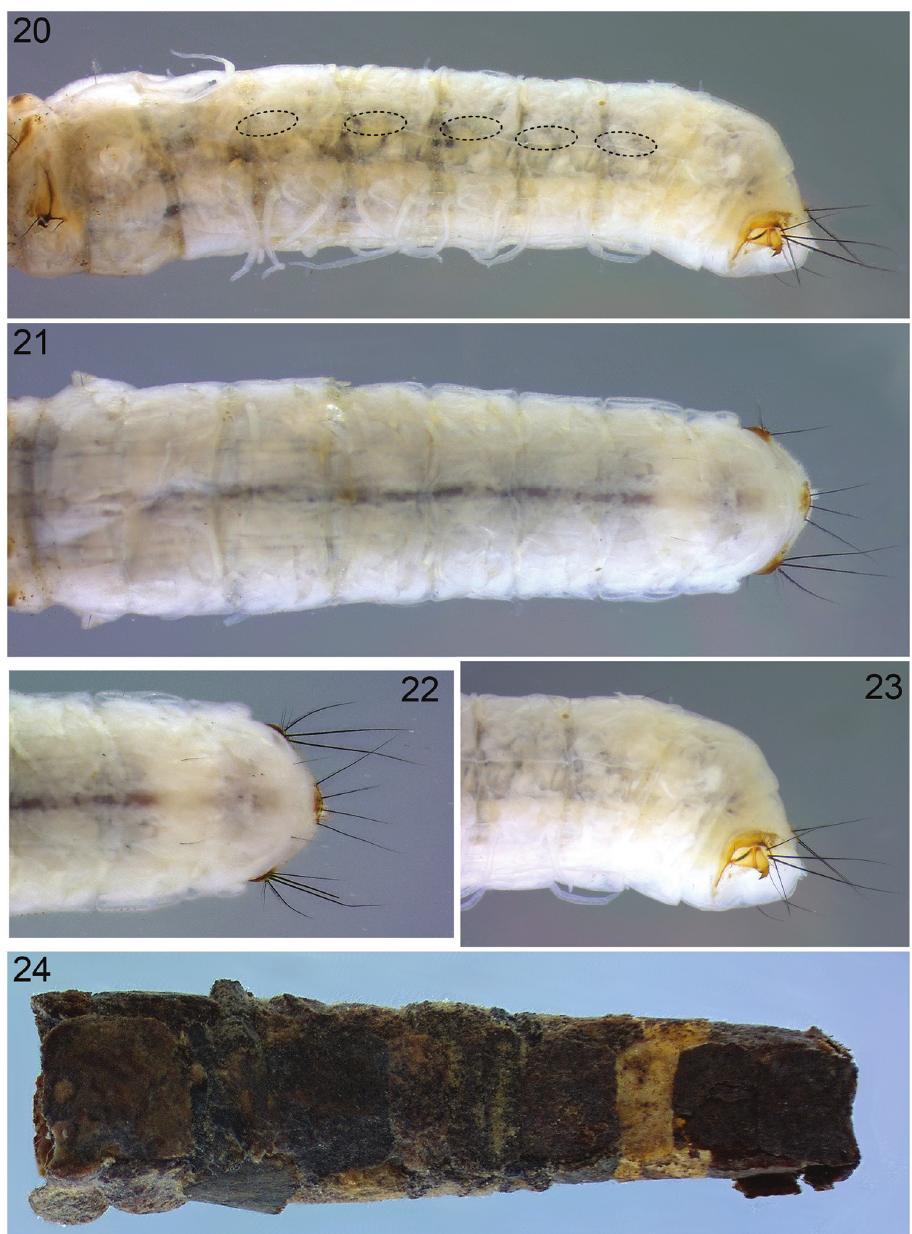
Figures 20–24. Lepidostoma scotti , 5 th instar larva . 20 Abdomen, segments I-X, lateral view (dashed ovals indicate position of forked lamellae), 13× 21 Abdomen, segment I-X, dorsal, 13× 22 Abdominal segment VII-X, dorsal, 25× 23 Abdomen, segment VII-X, lateral, 25×; 24 Larval case, left lateral view,